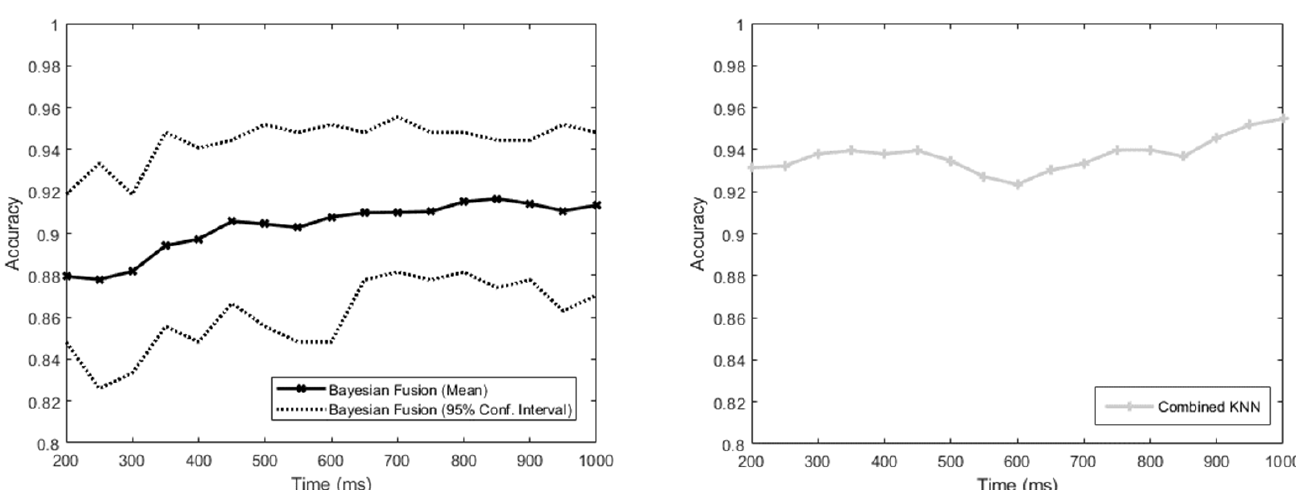
Figure 5. Graphs to show the accuracy of the intent-classification system against the time allowed to pass after the activity’s inception before classification was performed, up to the 1-second limit and with all 24 sensors active (no dropout). These graphs are shown separately to clearly illustrate the presence of a general trend for each algorithm, but comparisons between the two in this context should be avoided (see Section 4.1 for discussion on this). The Combined KNN method does not have confidence intervals, as all the sensors are included and there is no subdivision of the training data, so its performance is entirely reproducible.